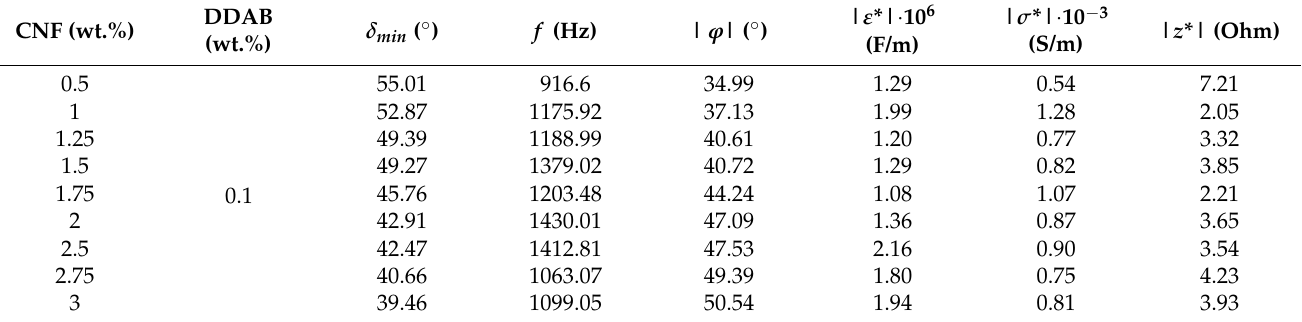
Figure 5. Graphs of permittivity and loss angle dependence on frequency for ( a , d ) CNF series with 0.1 wt.% DDAB, ( b , e ) CNF series with 0.5 wt.% DDAB and ( c , f ) DDAB series with 1 wt.% CNF, respectively. ( g ) δ min as the function of CNF content and the phase-separated sample show an obvious unfitting. Table 2. Values of minimum loss angle during the whole frequency range and corresponding | ϕ |, | σ ∗ | , | ε ∗ | , and | z ∗ | dependence on different CNF or DDAB contents at same state. CNF